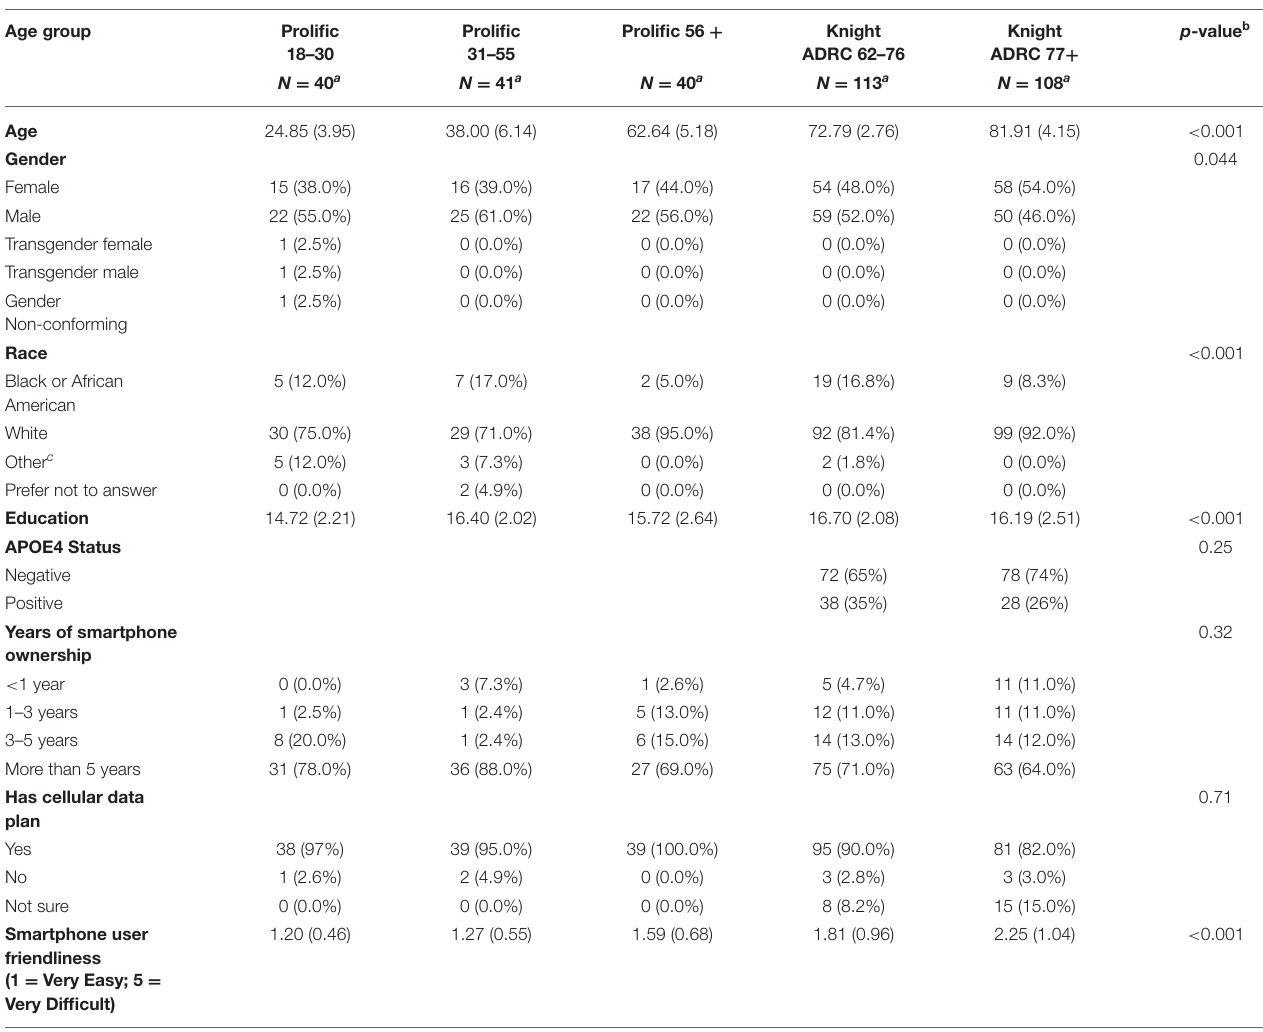
TABLE 1 | Demographic